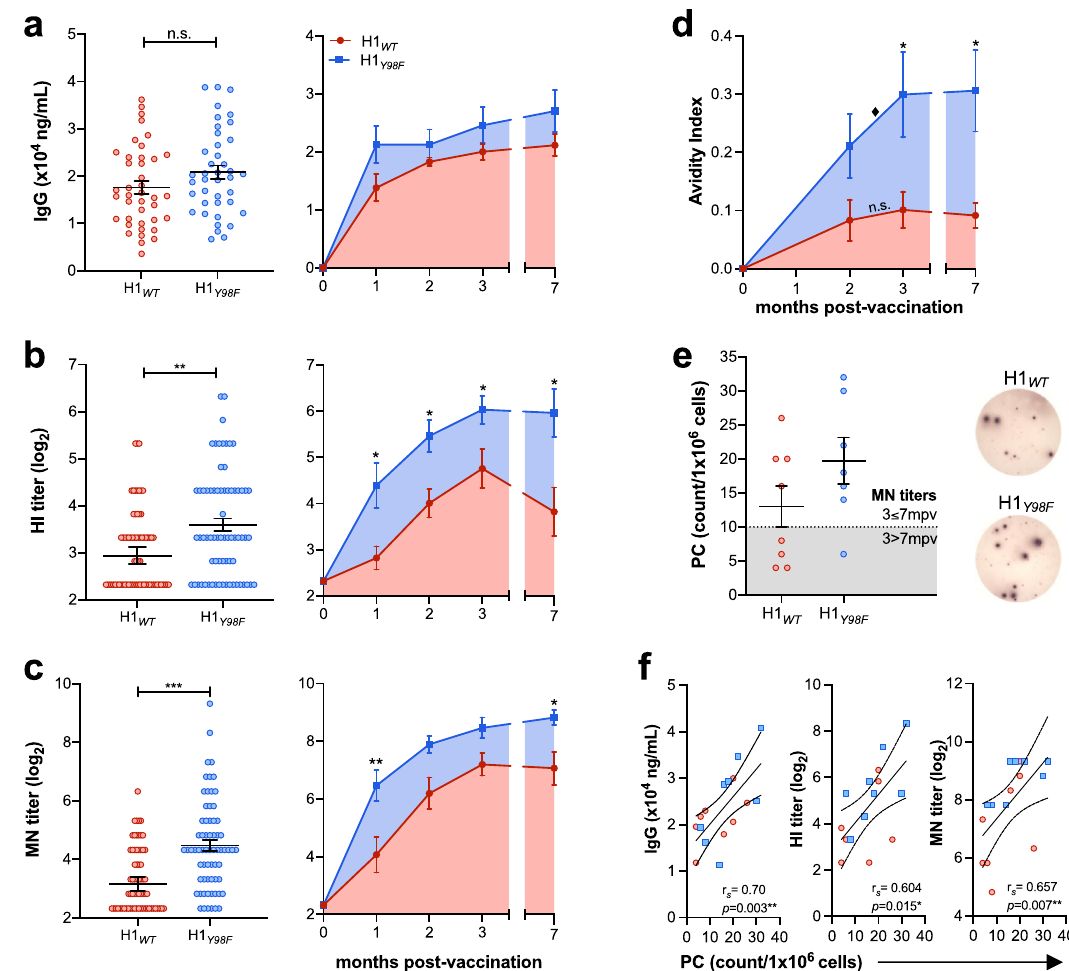
Fig. 2 H1 Y98F -VLP elicits a more robust and durable antibody response. Mice were vaccinated (IM) with H1 WT - or H1 Y98F -VLP (3 µg/dose). Sera were collected at day 21 (left panel) or on a monthly basis (right panel) to measure ( a ) total H1-speci fi c IgG by ELISA, ( b ) hemagglutination inhibition titers and ( c ) microneutralization titers. d Avidity indices of sera obtained 2 – 7 mpv following incubation with 8 M urea. e H1-speci fi c IgG-producing plasma cells (PC) in the bone marrow measured by ELISpot. Representative wells from each group are shown on the right. f Spearman ’ s rank correlation technique was applied to evaluate the relationship between the frequency of PC and IgG titers (left), HI titers (middle) and MN titers (right). Error bars represent the mean ± SEM. At day 21, N = 40 – 70/group and data are pooled from six independent experiments. For long-term studies, N = 7 – 8/group. Statistical signi fi cance between vaccine groups was determined by Mann – Whitney test (* p < 0.033, ** p < 0.01, *** p < 0.001). Statistical signi fi cance between time points within the same group was determined by two-way ANOVA with the Geisser-Greenhouse correction and Sidak ’ s multiple comparisons ( ♦ p <